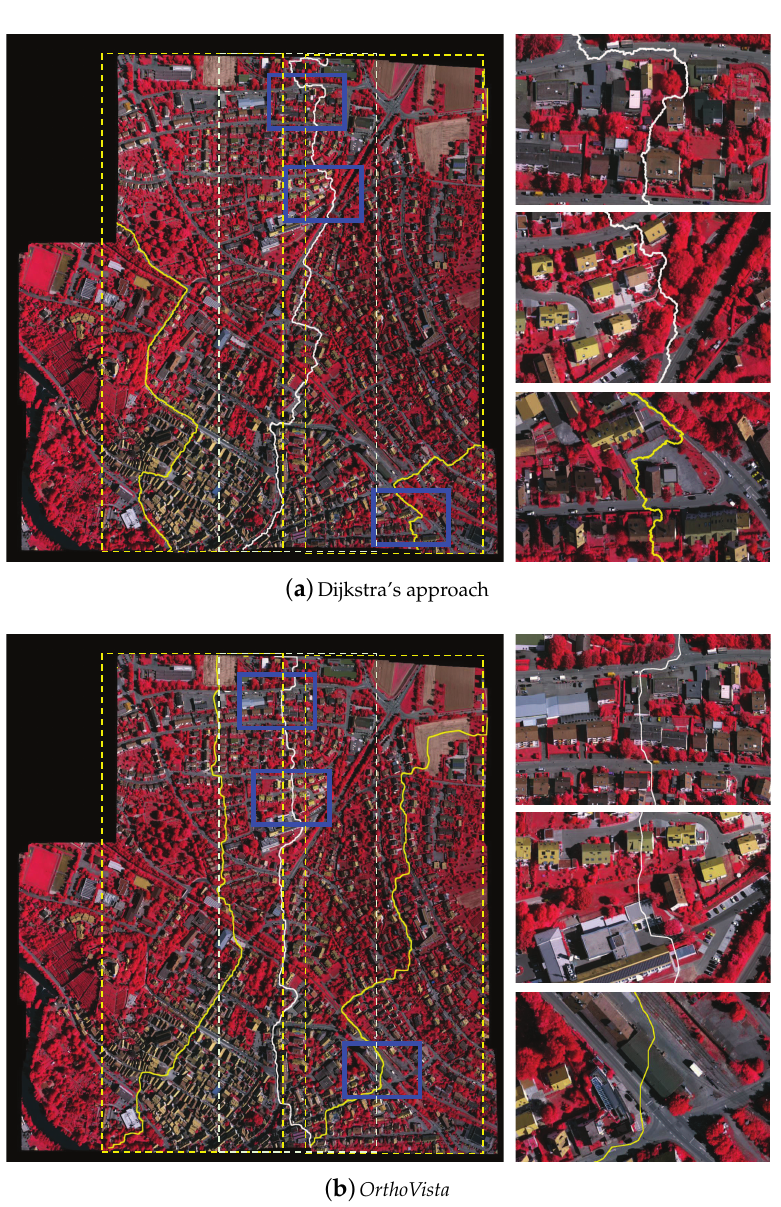
Figure 10. The seamline detection results generated by Dijkstra’s approach ( a ) and a commercial software OrthoVista ( b ). The dash boxes represent the overlapped regions between input images. The dash boxes represent the overlapped regions between input